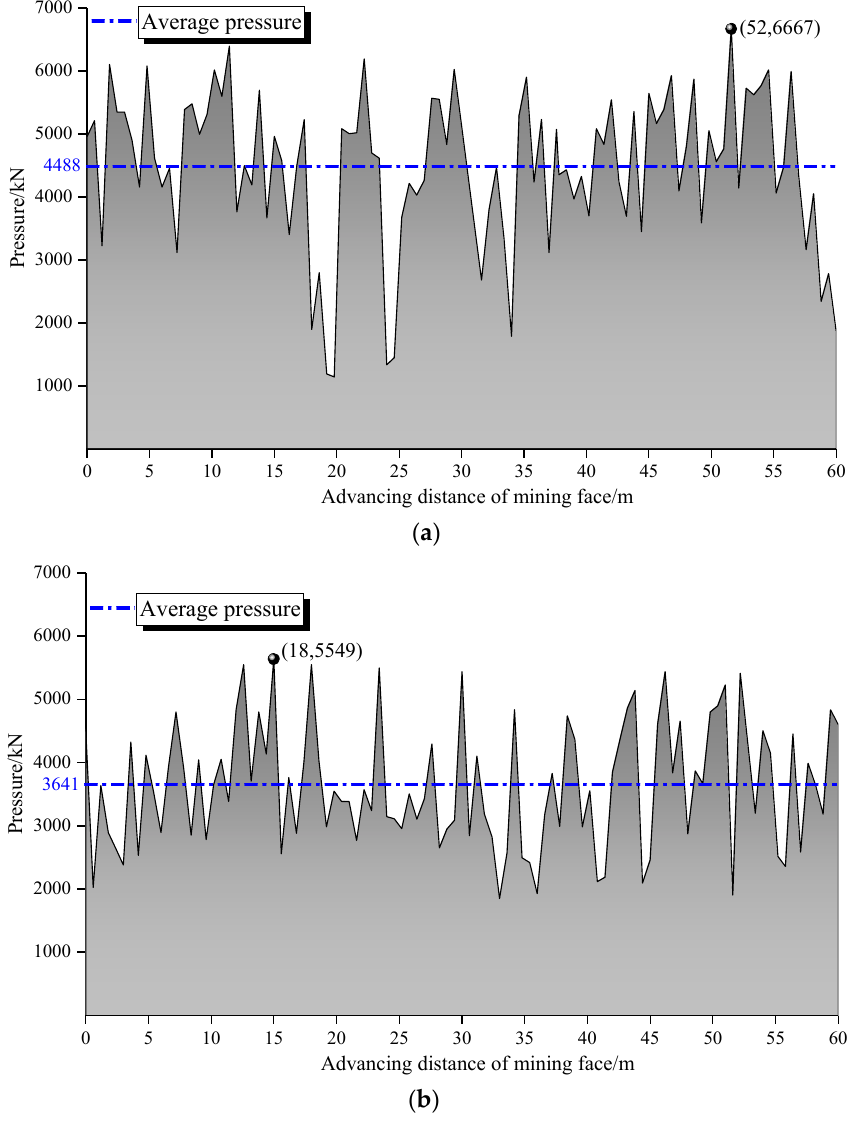
Figure 12. Hydraulic support pressure monitoring results. ( a ) Roof non-presplitting side; ( b ) roof presplitting side.